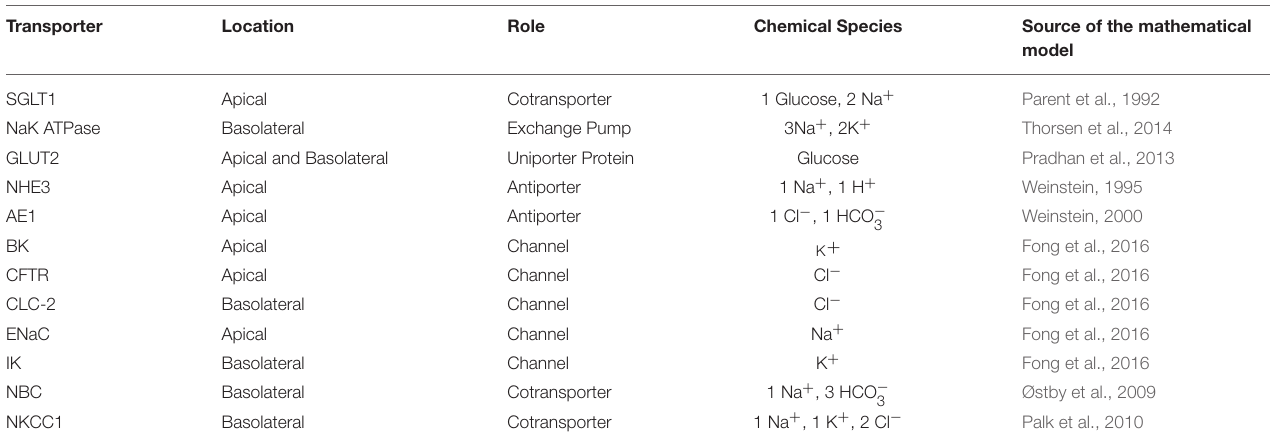
TABLE 1 | List of transporters used in the model along with their locations and roles.